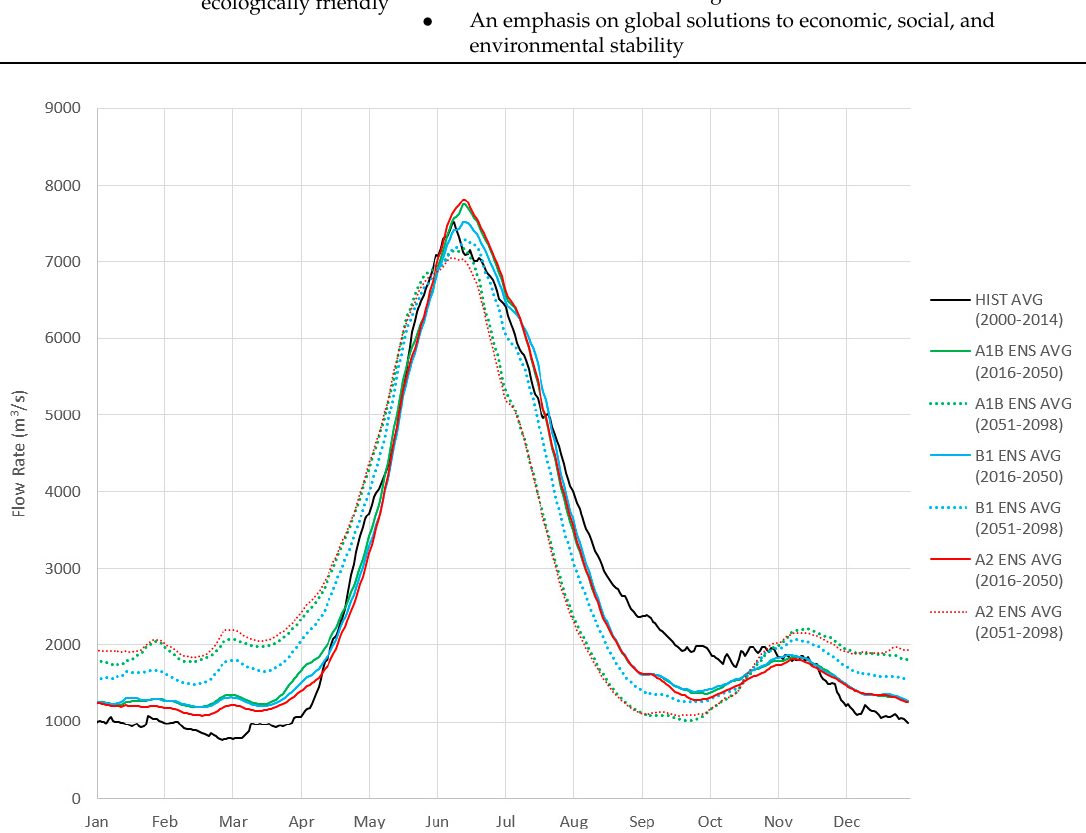
Figure 8. Ensemble historical and modelled daily Fraser River flow rate.